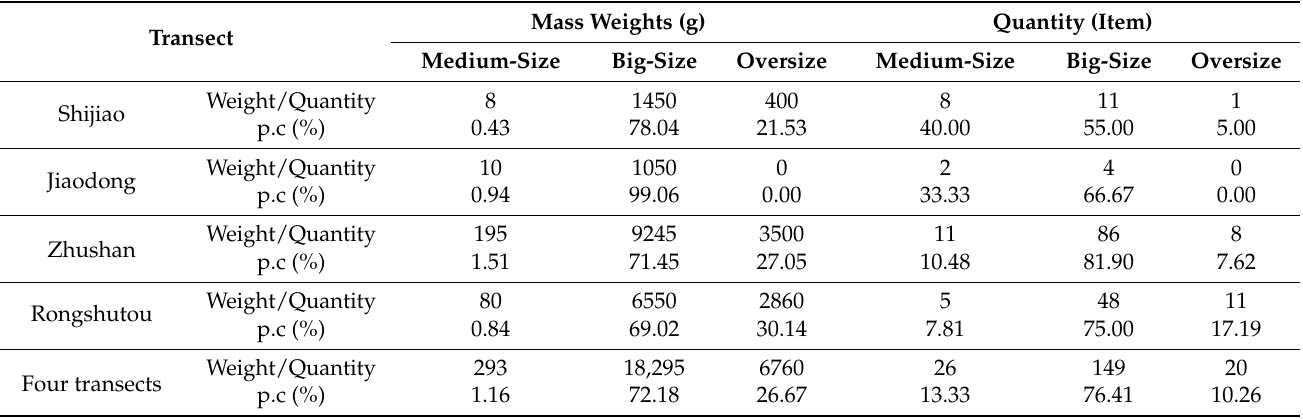
Table 6. Mass weights and quantity of marine debris items by